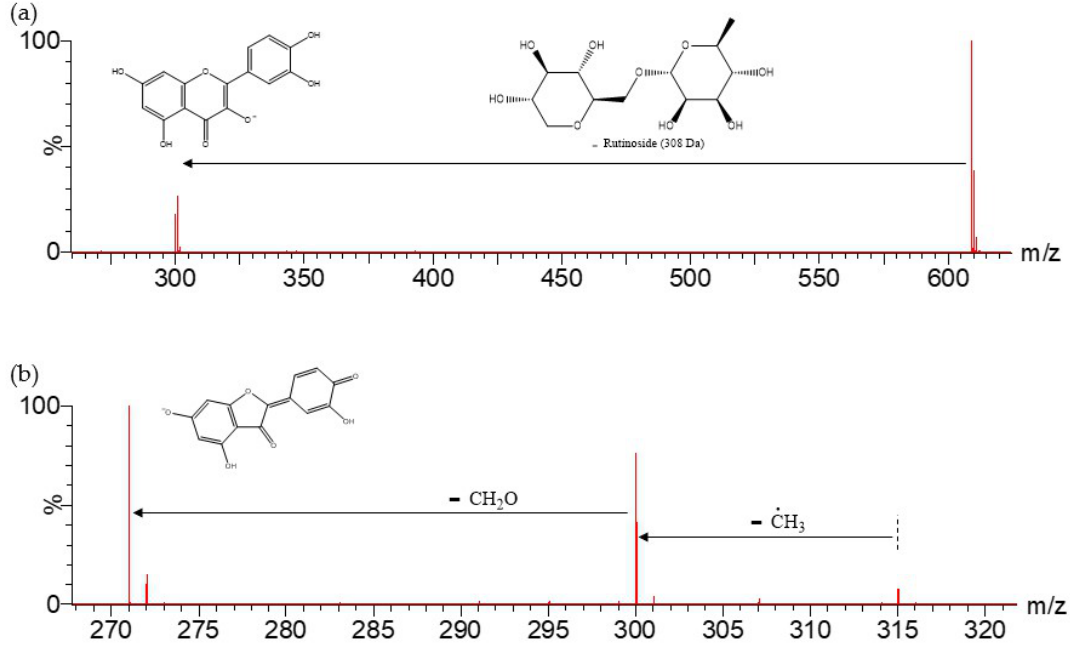
Figure 17. MS 2 spectra for ( a ) compound 9, [M-H] − = 609.1442, and ( b ) compound 31, [M-H] − = Figure 315.0504.